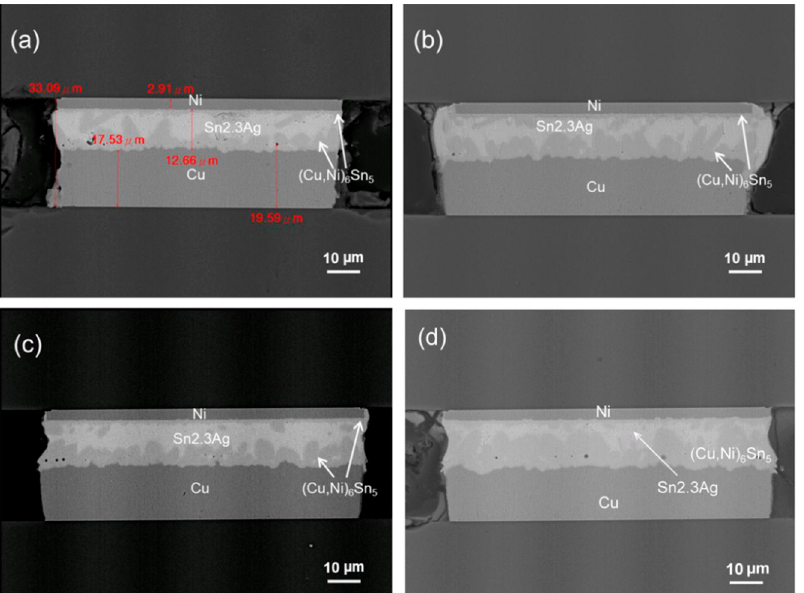
Figure 4. Cross-sectional SEM BEIs of the IMC-bridging Ni/solder/Cu microbumps reflowed for ( a ) 0 min, ( b ) 5 min, ( c ) 10 min, and ( d ) 30 min. Arrows designate the IMCs.